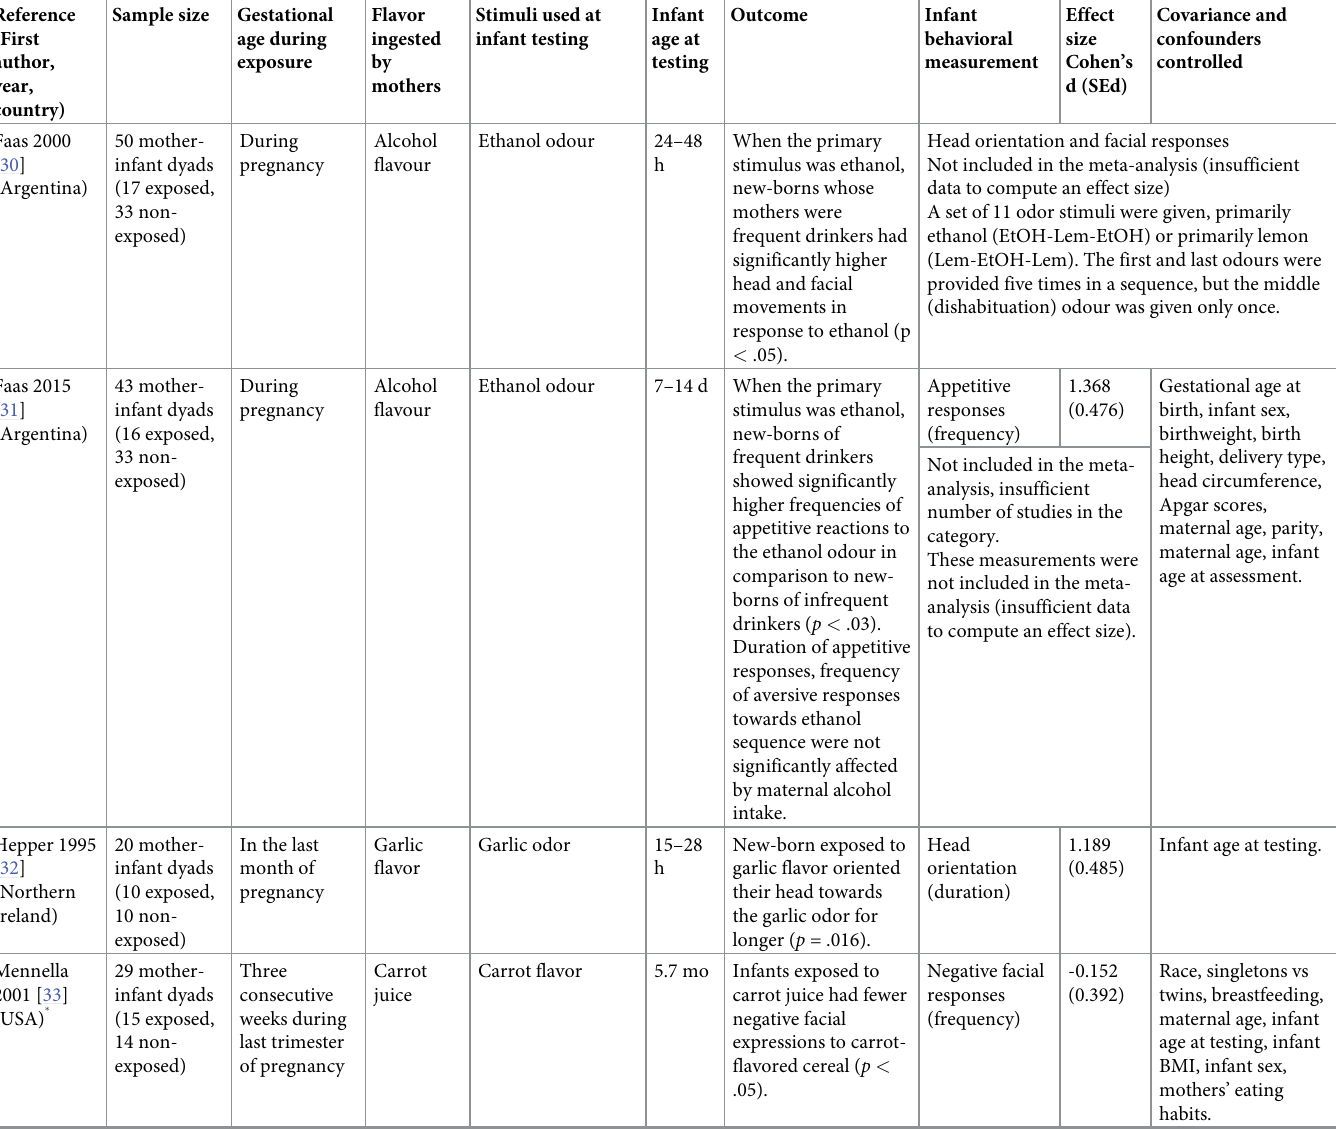
Table 2. Studies that compared the behavioral responses of infants whose mothers did or did not ingest the target flavor ( k =